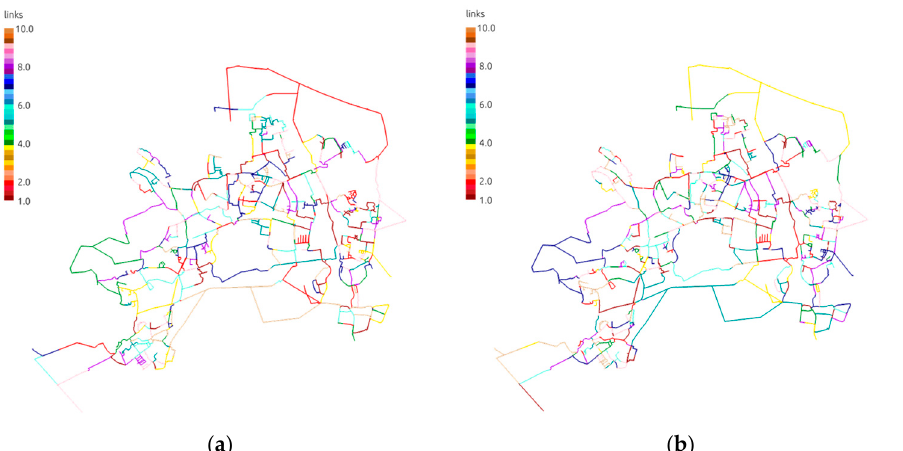
Figure 7. Transition phase wherein each pipe of the network should be replaced for ( a ) the solution identified with a blue circle on the Pareto front (Figure 6) and ( b ) the solution identified with a green circle on the Pareto front (Figure